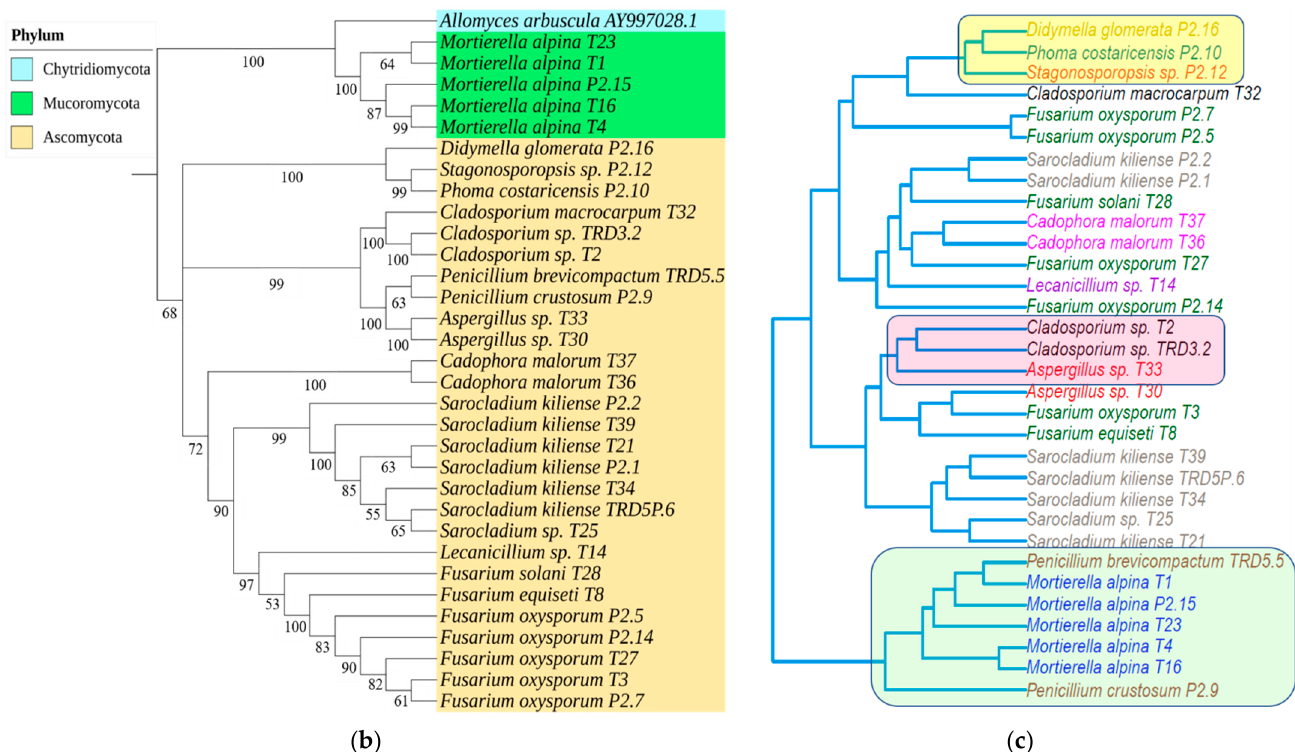
Figure 2. ( a ) Composition of the isolated fungal community and the phenotypes of 7-day-old cultures on Czapek-Dox agar, with percentages of species (BioRender, exported on 8 April 2021); ( b ) species phylogeny (neighbor-joining tree) based on internal transcribed spacer sequences ( Allomyces arbuscula AY997028.1 was used as an outgroup); and ( c ) dendrogram of hierarchical clustering analysis using the individual tolerance indices.